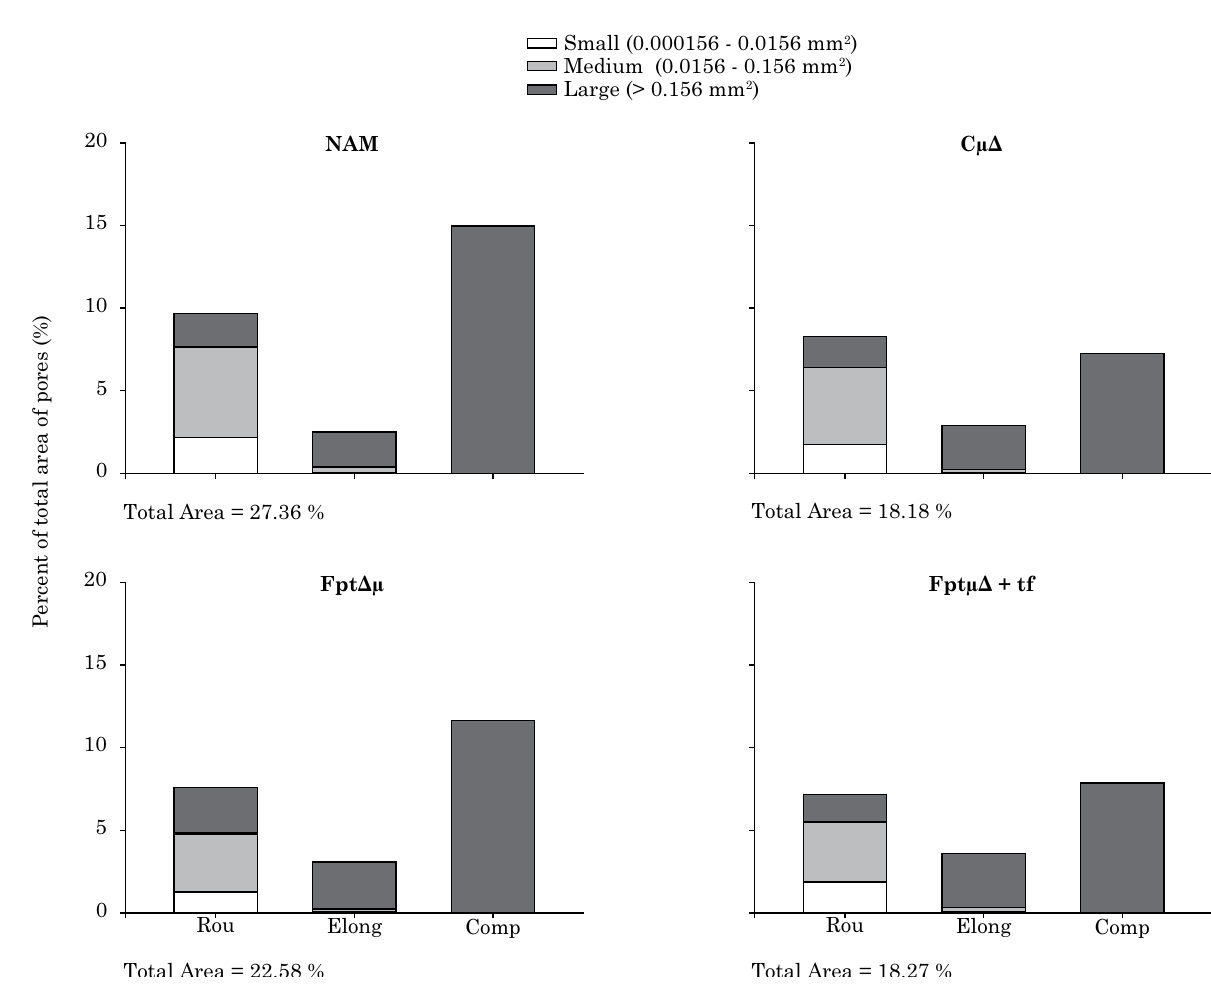
Figure 7. Distribution of the total area of pores according to shape and size of the pores observed in the MHUs of the Memory plot. Rou: rounded; Elong: elongated; Comp: complex. NAM: not altered by management; F or C: fragmented or continuous volumes of soil; ∆μ or μ∆: compact or porous clods, with aggregates that are very compact (∆), compact (∆μ) and in the process of compaction (μ∆); pt, mt, gt: small, medium, or large clods; and tf: fine